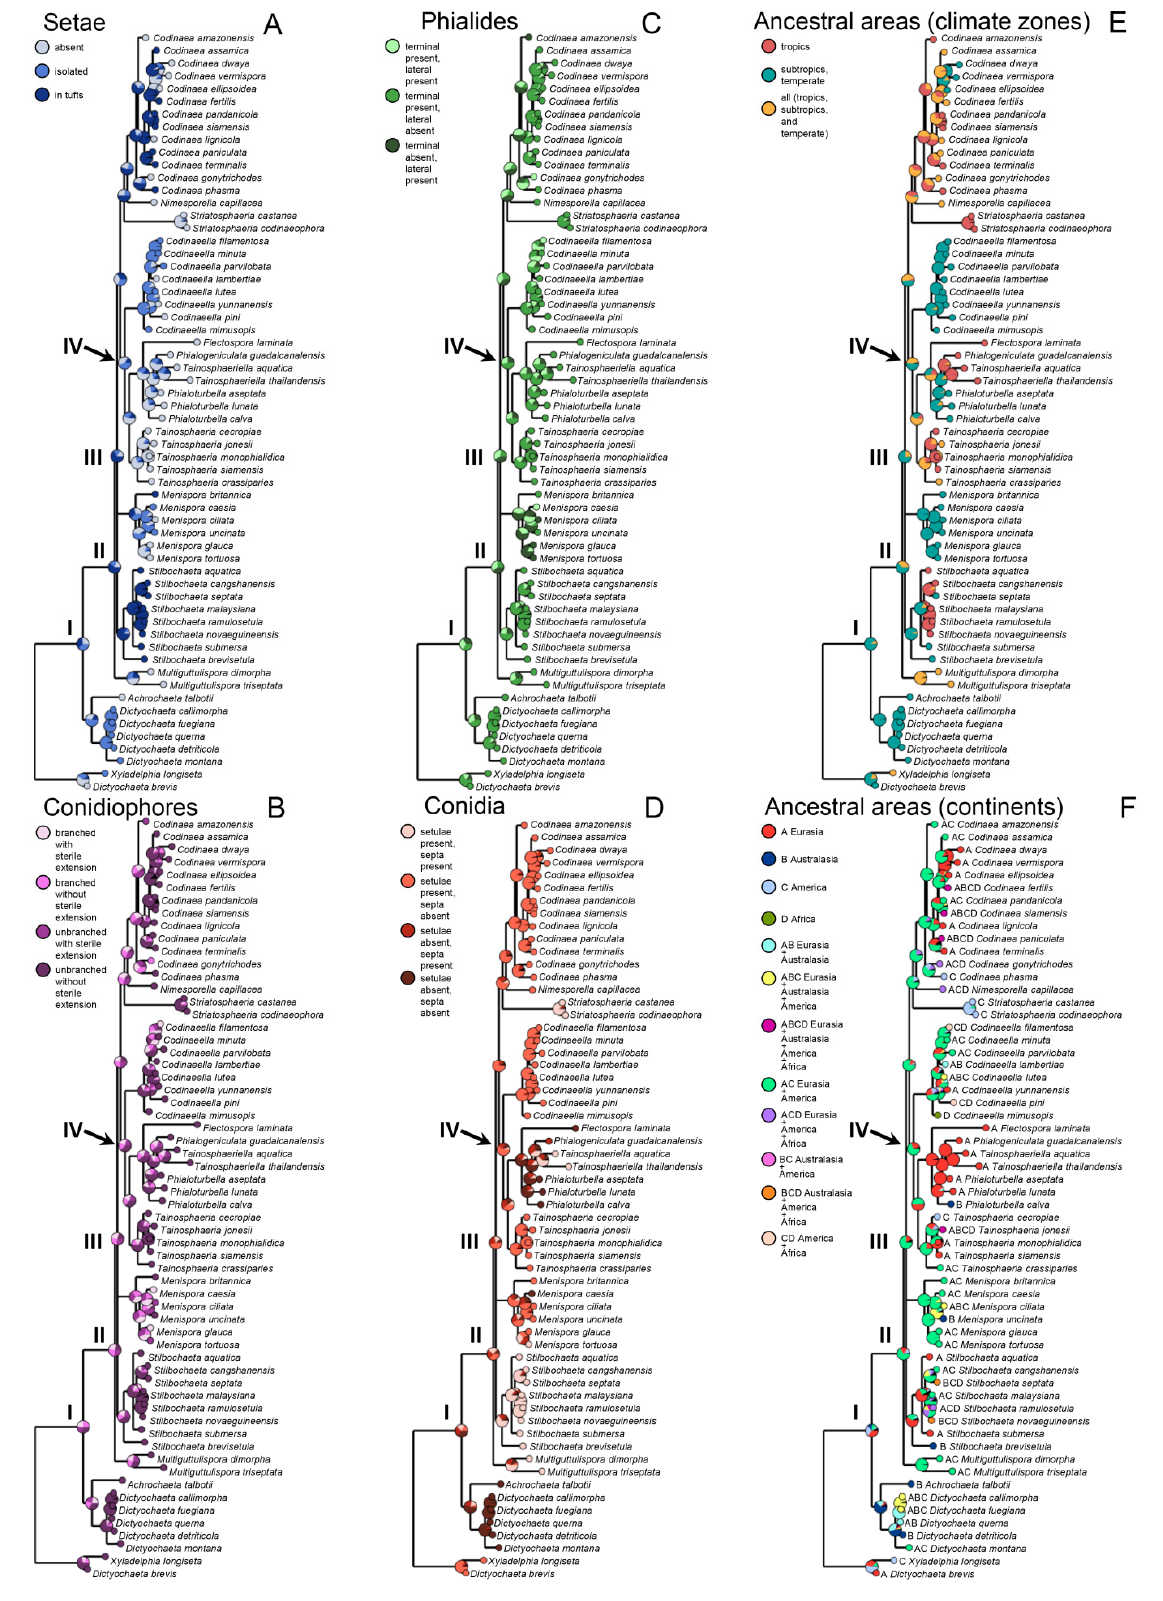
Figure 6. Reconstruction of ancestral states and areas in Rasp v.4.2 using phylogenetic trees calculated in MrBayes v.3.2.7. ( A – D ) Reconstruction of morphological characters using Multistate function in Bayestraits ( E , F ) ancestral areas reconstruction of species distribution using Bayesian Binary MCMC (BBM) method.